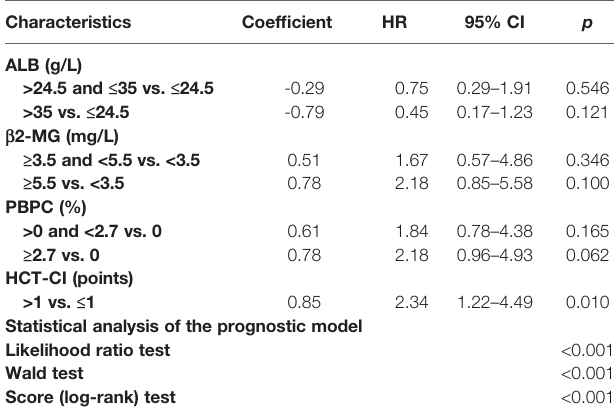
TABLE 2 | Multivariate Cox regression analysis of variables included in the MM- BHAP model in the development cohort. Characteristics Coef fi cient HR 95% CI p ALB (g/L) >24.5 and ≤ 35 vs. ≤